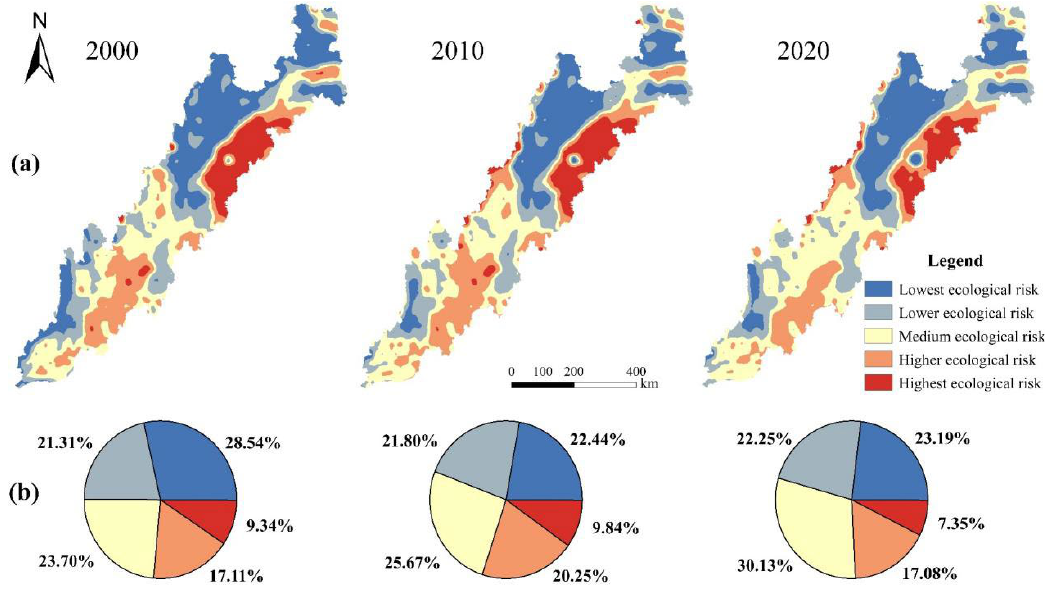
Figure 3. Spatial distribution ( a ) and proportion ( b ) of ecological risk in the Sichuan-Yunnan Ecological Barrier from 2000 to 2020.